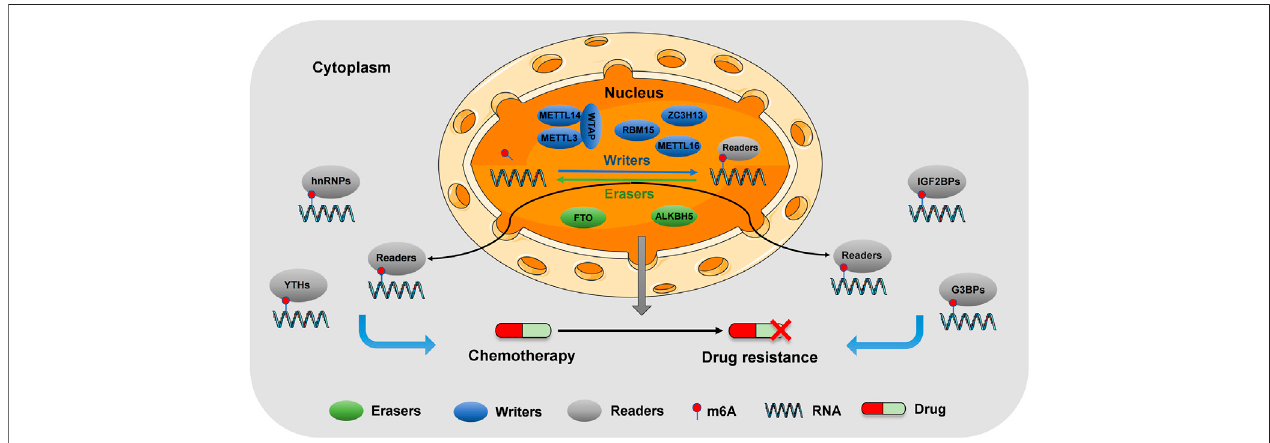
FIGURE 1 | Molecular mechanisms of m6A modi fi cation in digestive tumors. m6A modi fi cation is a dynamic and reversible process. Methyltransferase complexes (writers)catalyzem6Amethylation, demethylase(erasers)reverse m6Amethylation,andm6Abindingprotein (readers)promoteitsfunction.m6Amethylationisinvolved in carcinogenesis and chemotherapy resistance of digestive